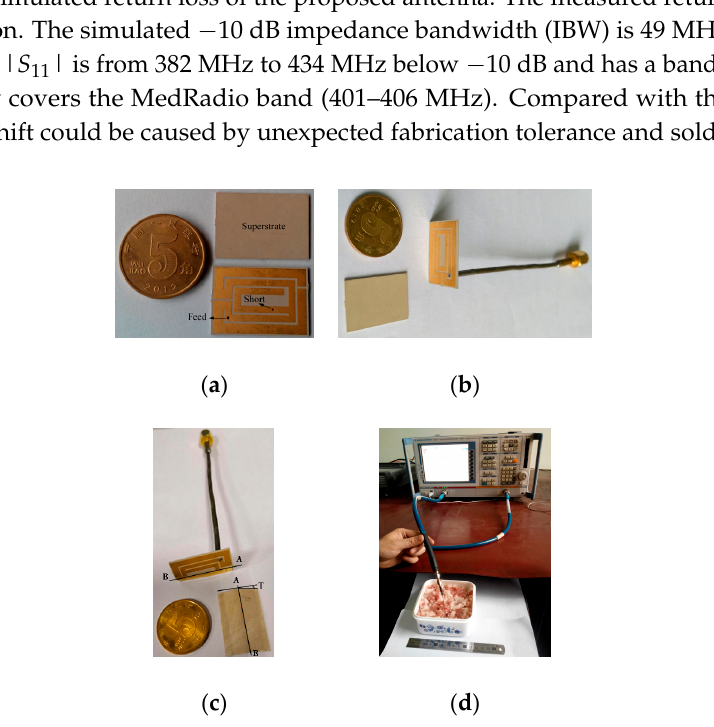
Figure 5. Photographs and experimental setup of the proposed antenna. ( a ) Photograph of the exploded flat antenna; ( b ) photograph of the assembled planar antenna; ( c ) photograph of the assembled bent antenna; ( d ) experimental setup.